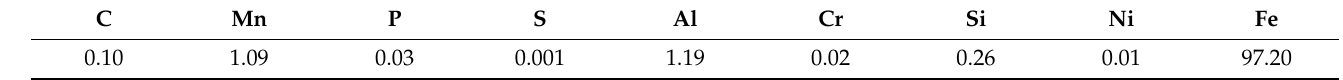
Figure 2. Microstructure of the DP600 welded structure [19]. Table 1. The main chemical compositions of DP600 in weight percentage